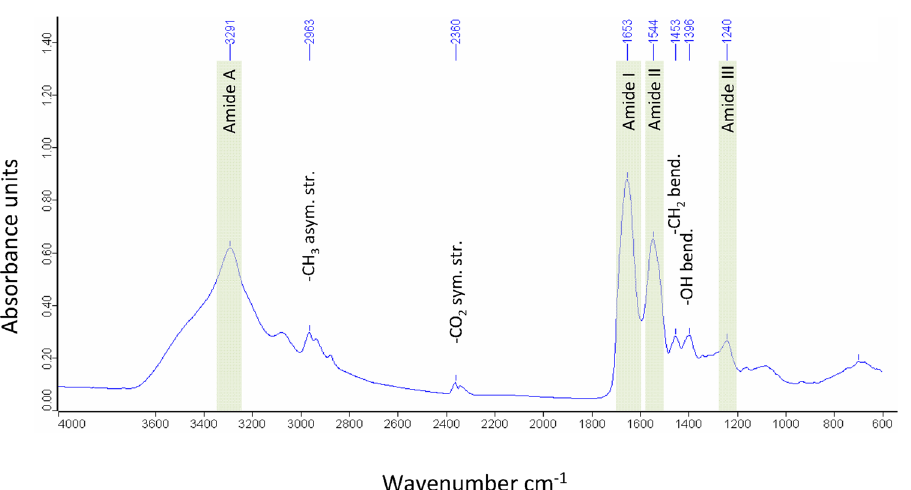
Figure 3. FTIR spectrum of dry salamander secretion. The region between 4.000 and 600 cm − 1 is magnified and prominant vibrations from amide bonds have been colored